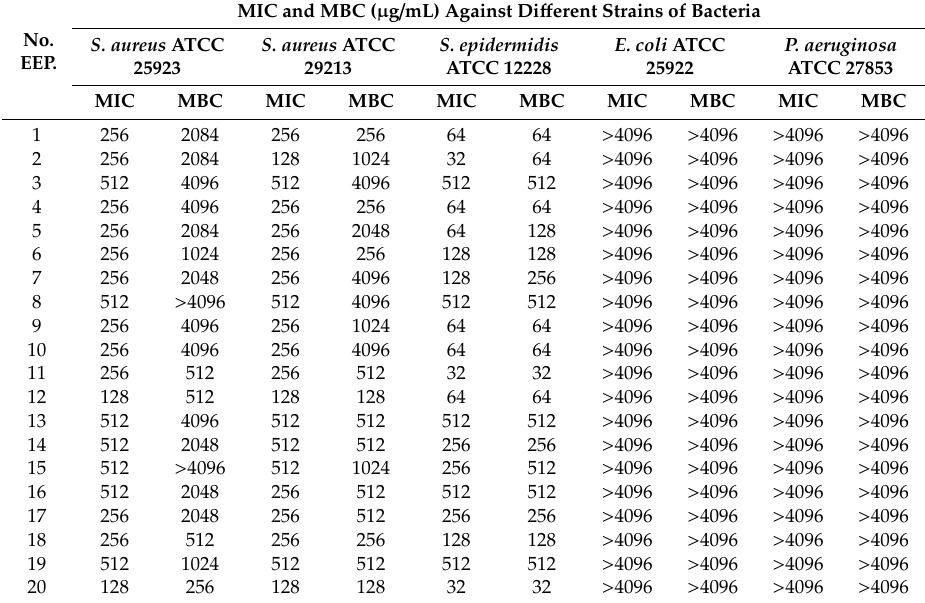
Table 1. Antibacterial activity of ethanol extracts of propolis (EEPs) collected from apiaries located in di ff erent regions of Poland tested against reference strains of bacteria.